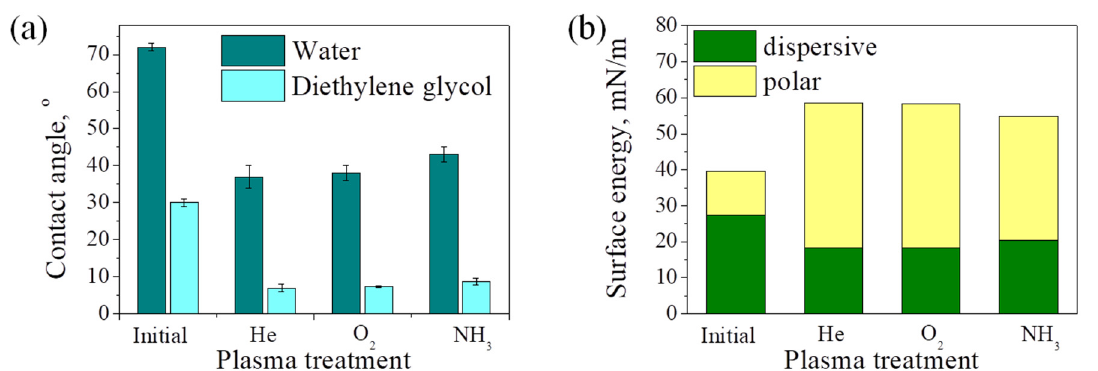
Figure 8. Behavior of the contact angle (water and diethylene glycol) ( a ) and surface energy ( b ) in dependence on plasma treatment chemistry.